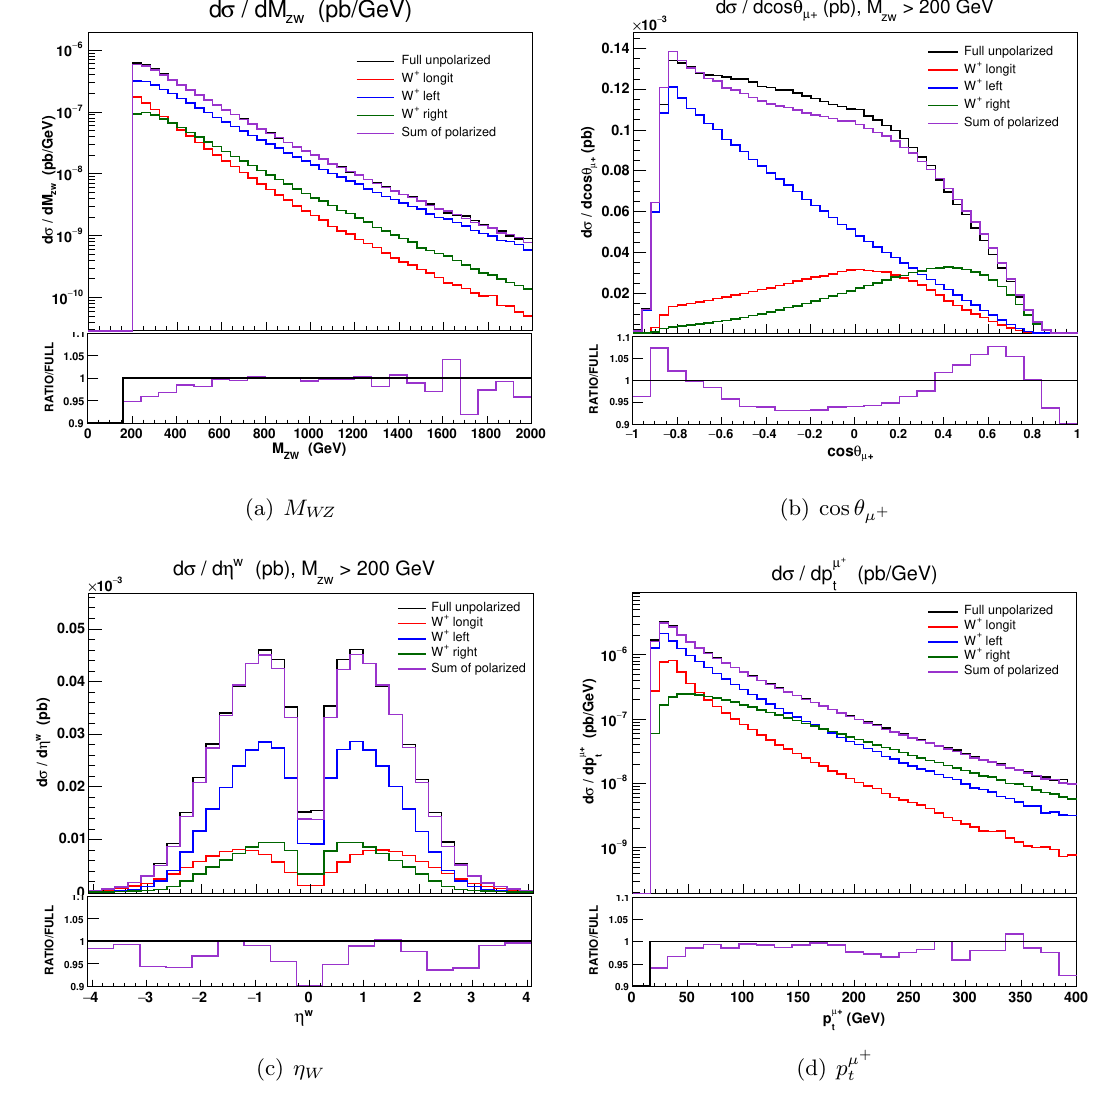
Figure 7 . W + Z scattering: di(cid:11)erential cross sections for a polarized W + boson, in the presence of lepton cuts and neutrino reconstruction. We show the full result (black), the single polarized distributions (red: longitudinal, blue: left handed, green: right handed) and the incoherent sum of the polarized results (violet). The pull plot shows the ratio of the sum of polarized distributions to the full